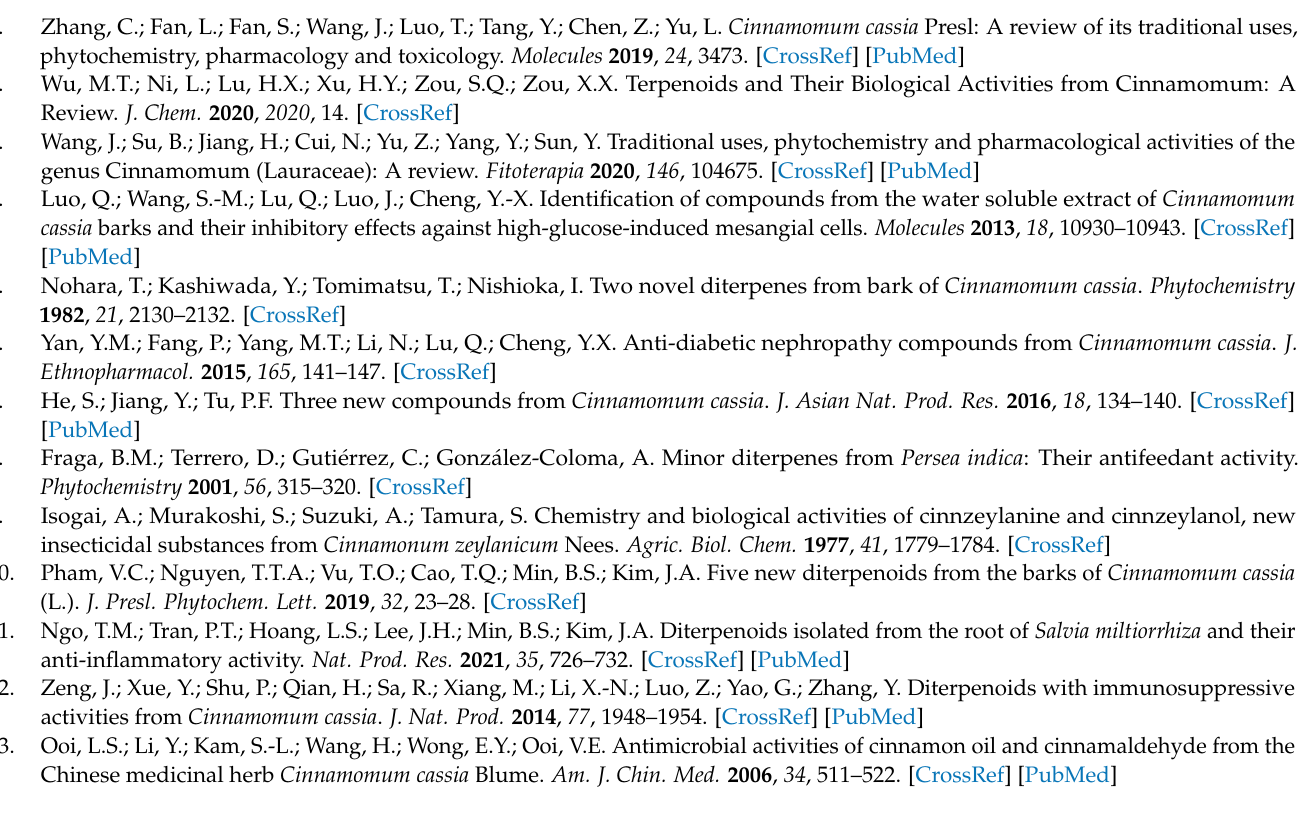
S4: MS/MS spectra of dehydrogenated M12 (A) and M13 (B) using a high-resolution quadrupole- orbitrap mass spectrometer. Figure S5: MS/MS spectra of dehydrogenated M15 (A) and M19 (B) using a high-resolution quadrupole-orbitrap mass spectrometer. Figure S6: MS/MS spectra of dehydrogenated M17 (A), M18 (B), and M20 (C) using a high-resolution quadrupole-orbitrap mass spectrometer. Figure S7: Effect of a nonspecific CYP inhibitor, SKF 525-A, in the metabolism of AHC in HLMs. Inhibition of AHC metabolism following SKF-525 treatment (0, 0.25, and 1.25 mM) (A). Decreased production of M1 , M2 , and M3 (B); M4 – M10 (C); M11 – M13 (D); and M14 – M20 (E). The data are expressed as means ± standard errors (SE) of the triplicate samples. Figure S8: Formation of AHC metabolites in recombinant cDNA-expressed CYP3A5 after incubation at 37 ◦ C for 60 min. Table S1: Elemental composition of key product ions of anhydrocinnzeylanine and its metabolites in human liver microsomes using high-resolution quadrupole-orbitrap mass